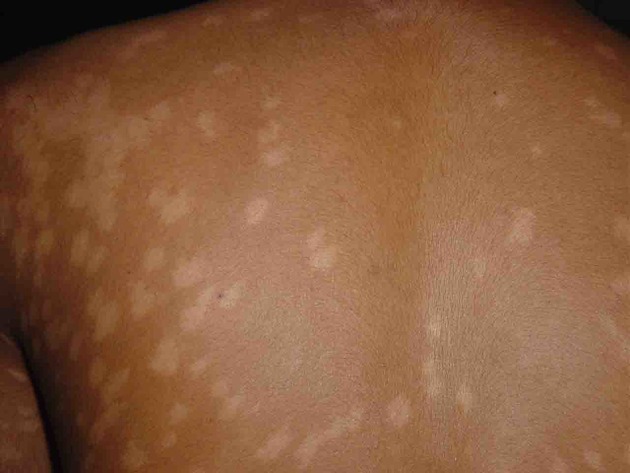
A macular rash in a patient from Bangladesh; the macules vary in size and some are confluent.